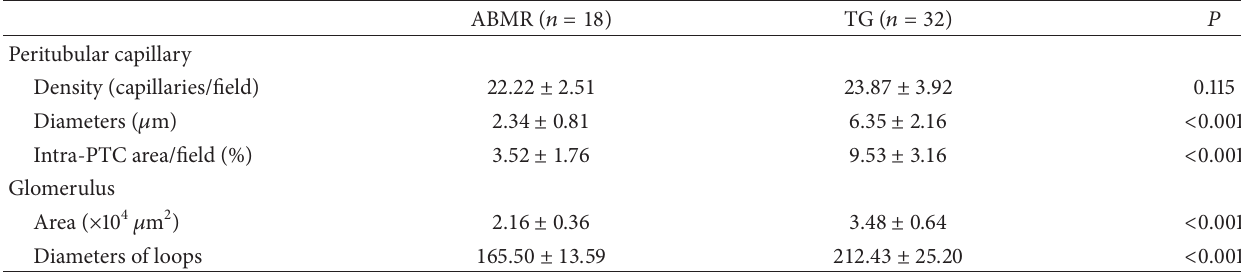
Table 5: Capillary variation between ABMR and